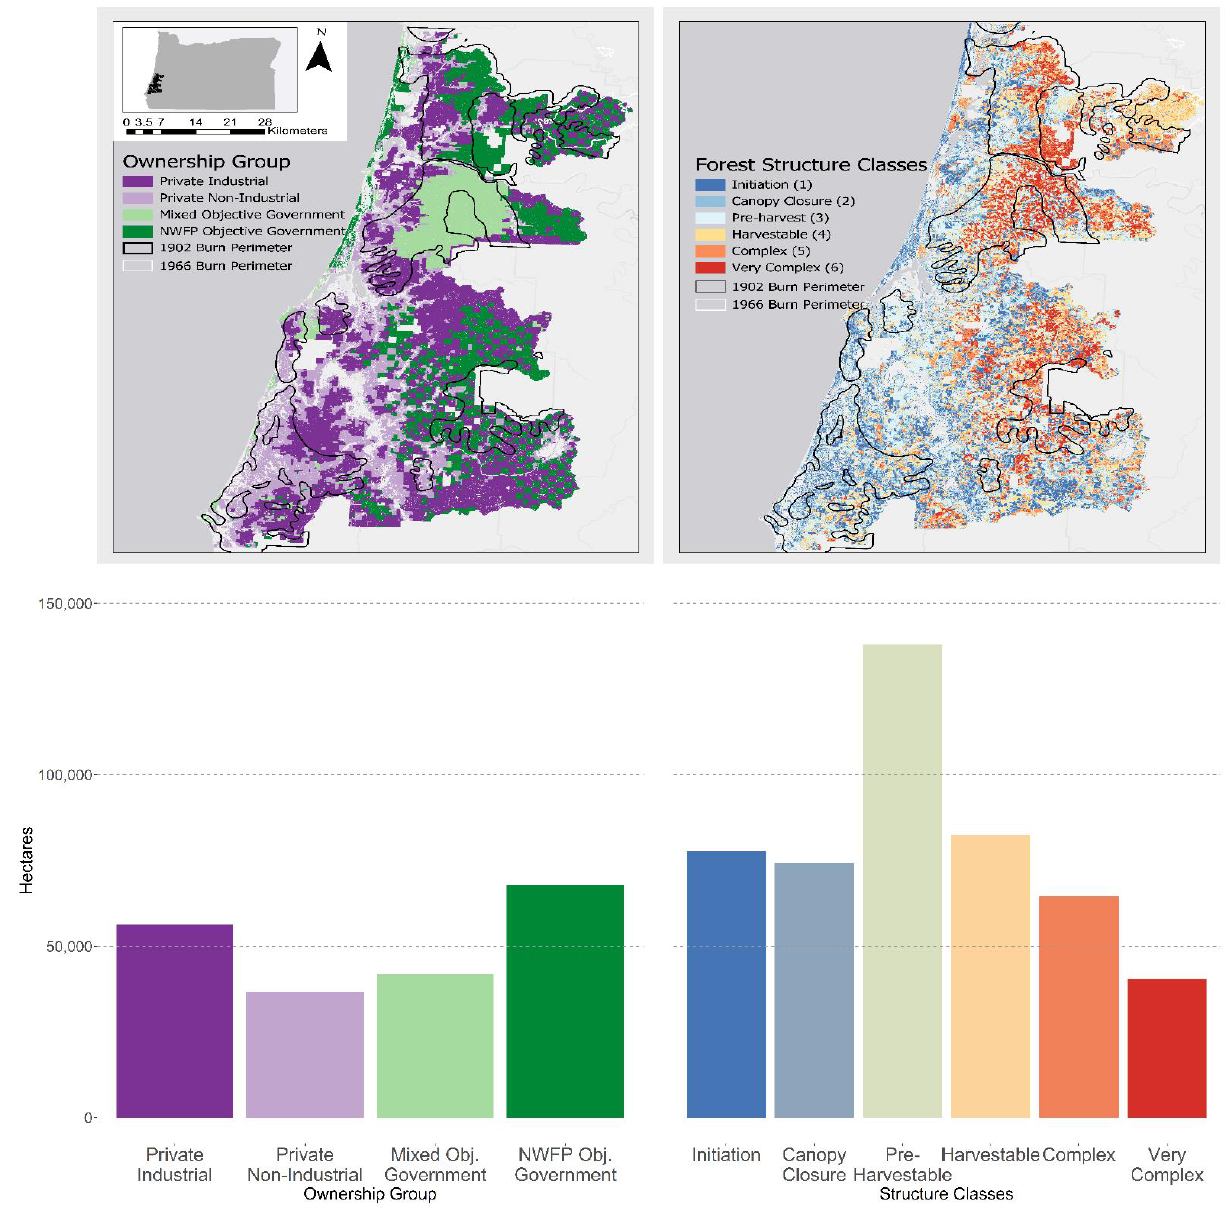
Figure 1. Maps of and hectares per ownership groups (Top left, bottom left) and forest structure classes (Top right, bottom right) in the study area. Ownership types are grouped by the ownership groups identified through hierarchical classification (Sections 2.5 and 3.2). Burn perimeters from the 1902 fires also appear on each map [54].